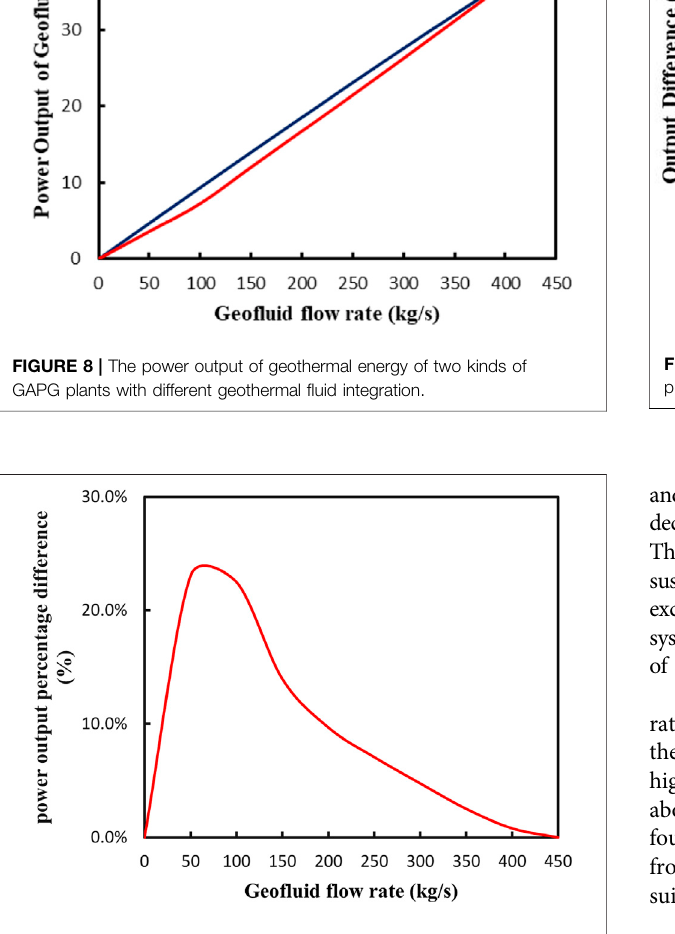
FIGURE 9 | Comparison of two kinds of GAPG plant output with same amount of geothermal integration.